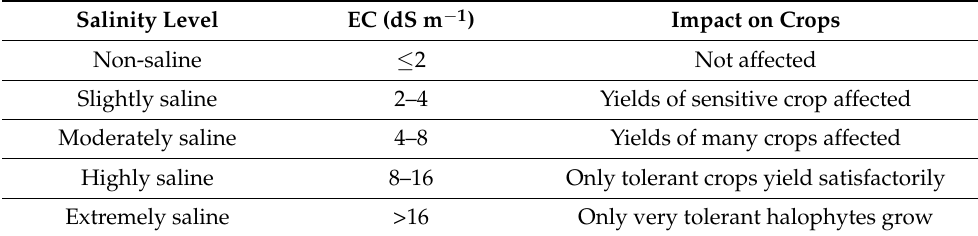
Figure 3. Salinity distribution maps for 1988 and 2019. Table 3. Classification of soil salinity based on electrical conductivity (EC) and crop